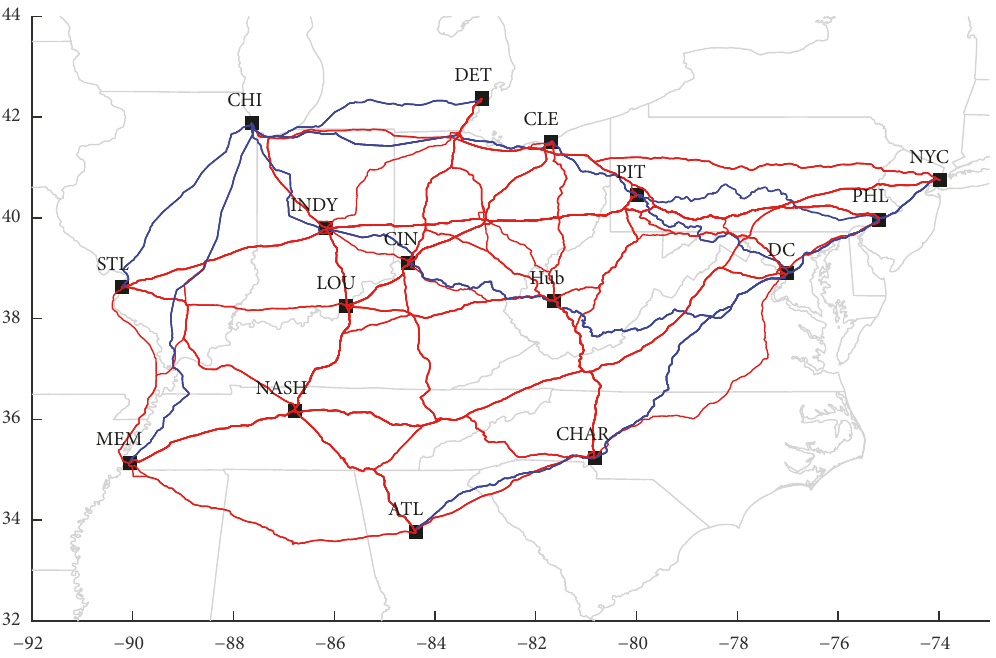
Figure 3: The entire transit network analyzed: blue = train travel exists with a distance of 1.2 times or less of driving distance; red = driving distances